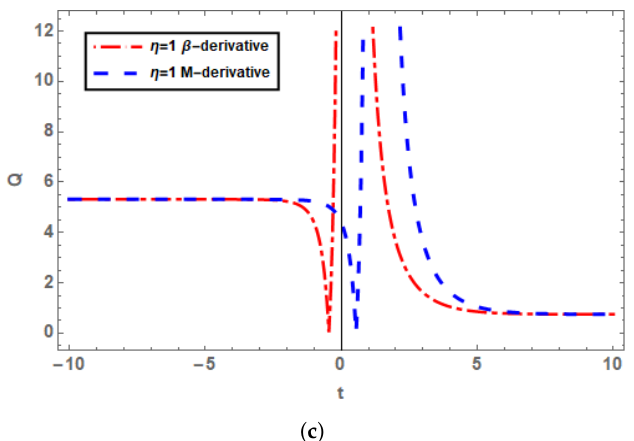
Figure 10. The 2 D profiles of Q 8,2 ( x , t ) for M-truncated and Beta operators with µ = 0.5, γ = − 0.8, σ = 0, θ = 1, ϑ = 1, (cid:101) = 0.5, λ = 1, and C = − 1 at t = 1.